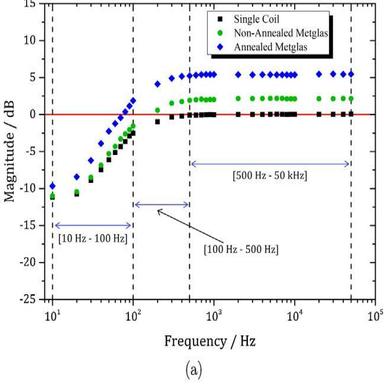
Frequency response graph in a logarithmic scale for three different sets of measurements.